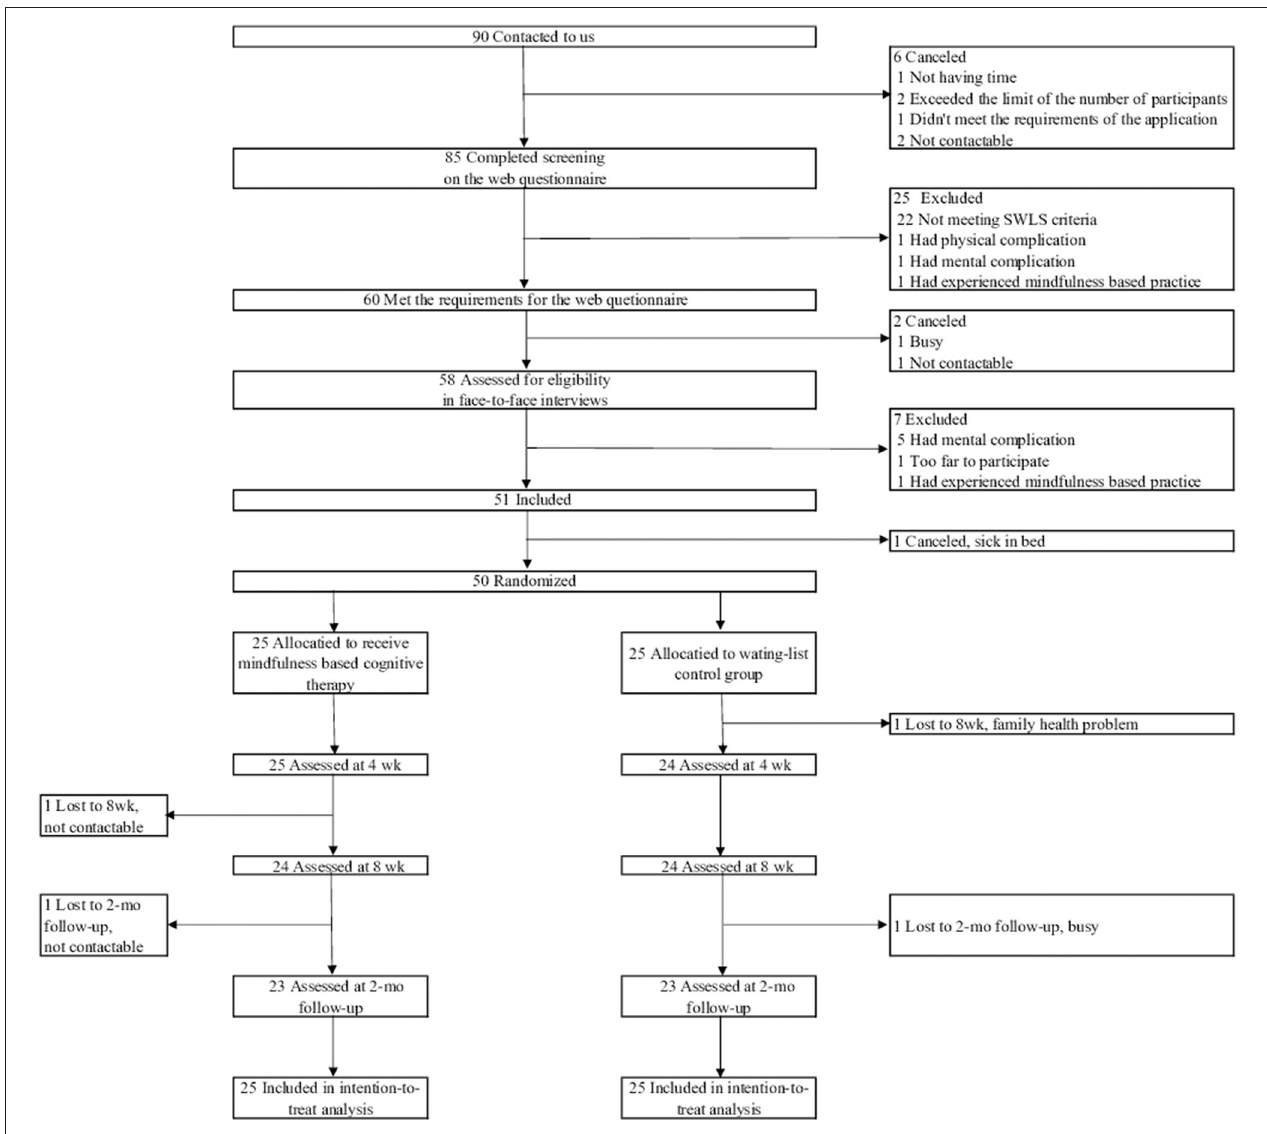
FIGURE 1 | Flow diagram of the